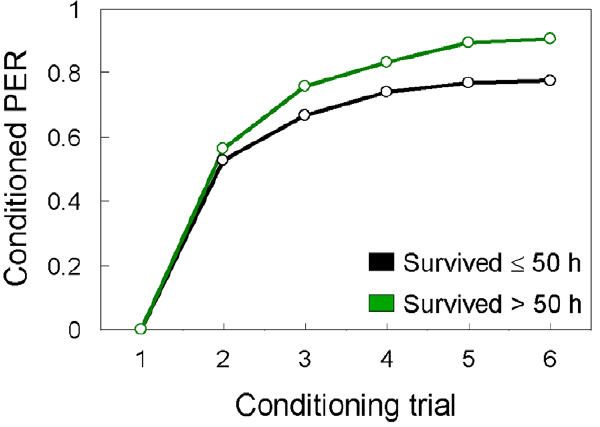
Figure 3. Olfactory learning in worker honeybees with different gustatory responsiveness. Acquisition (learning) curves for the proportion of bees that showed conditioned proboscis extension response (PER) to an odour in six conditioning trials. Bees with different responsiveness to sucrose are graphed separately. Low responsiveness (black line, N=63) refers to worker bees that did not respond to sucrose at # 0.1% in H 2 O; High responsiveness (green line, N=327) refers to bees that did respond to sucrose at # 0.1% in H 2 O. See text for details on statistics.